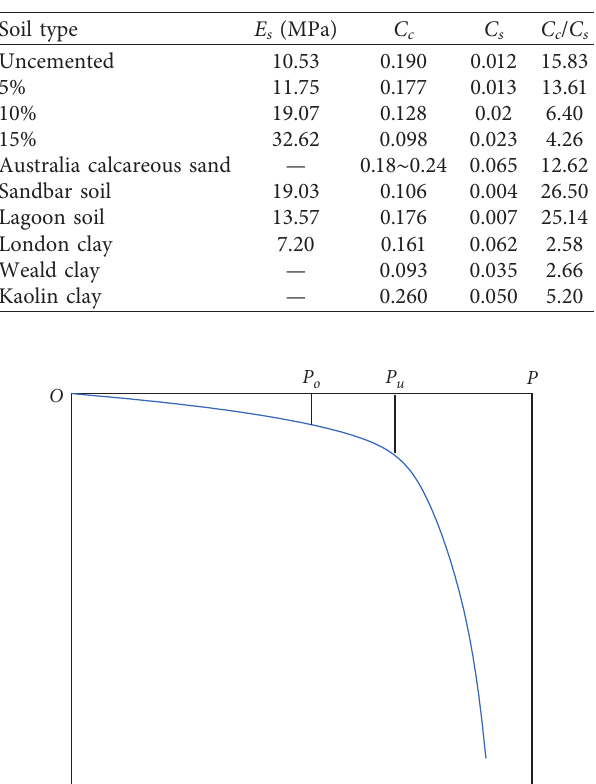
Figure 8: Bilogarithmic compression curves of calcareous sand with and without cement. Table 7: Compression parameters of different silts [19, 38].